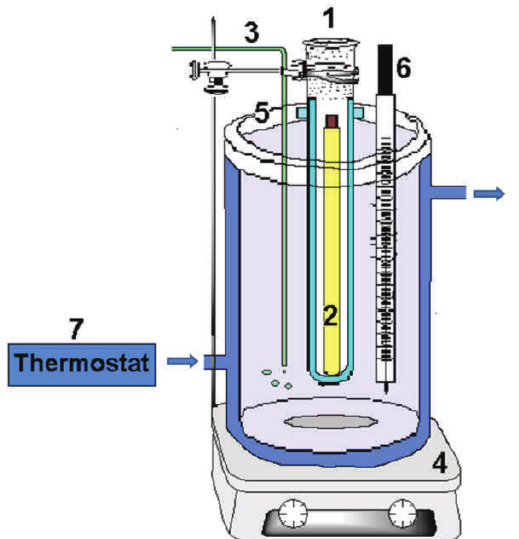
Figure 3. Experimental device for photocatalytic tests: 1 - Pyrex tap water cooling jacket (or quartz hollow jacket, when 17 W UV lamp with λ =254 nm is applied), 2 - lamp [halogen max (VIS), UV ( λ =365 nm or 254 nm)], 3 - constant air flow max (330 mL min -1 ), 4 - magnetic stirrer (600 rpm), 5 - double- walled reactor (equipped with water-cooling jacket, connected to a thermostat), 6 - thermometer (temperature of the slurry is carefully observed and maintained between 19 and 21ºC), 7 - thermostat (adjusted to maintain low temperatures of circulating water (~5°C), in order to compensate the heating power of the lamps and to assure constant temperature of the reaction suspension).